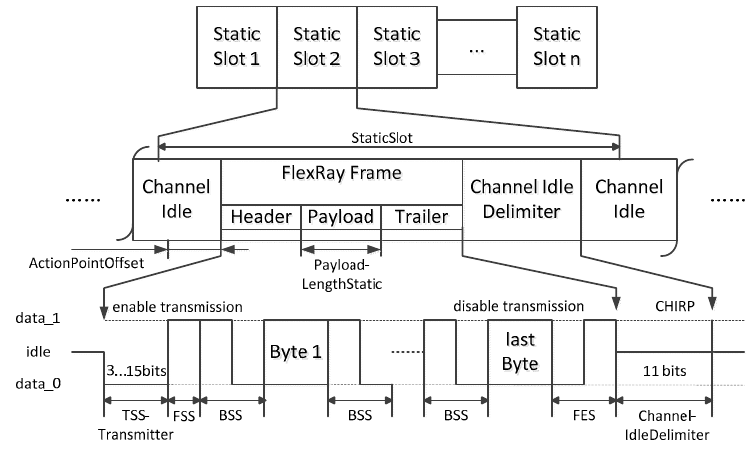
Figure 2. FlexRay message frame format.